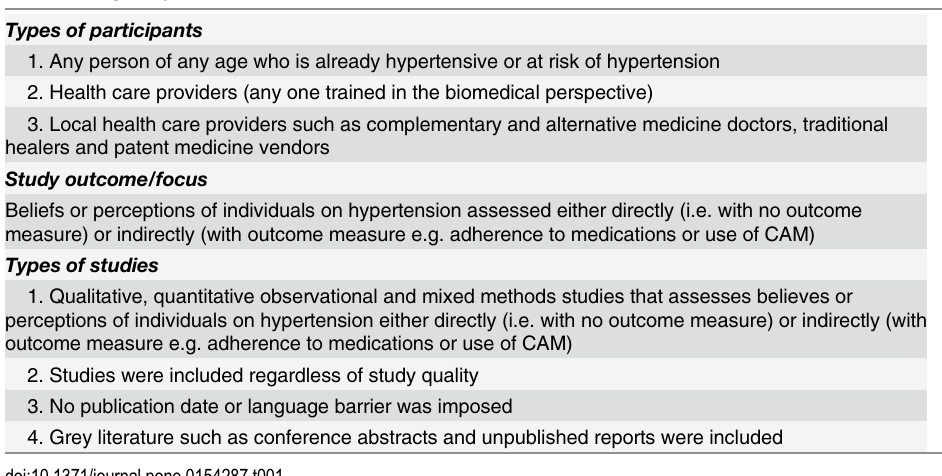
Table 1. Eligibility